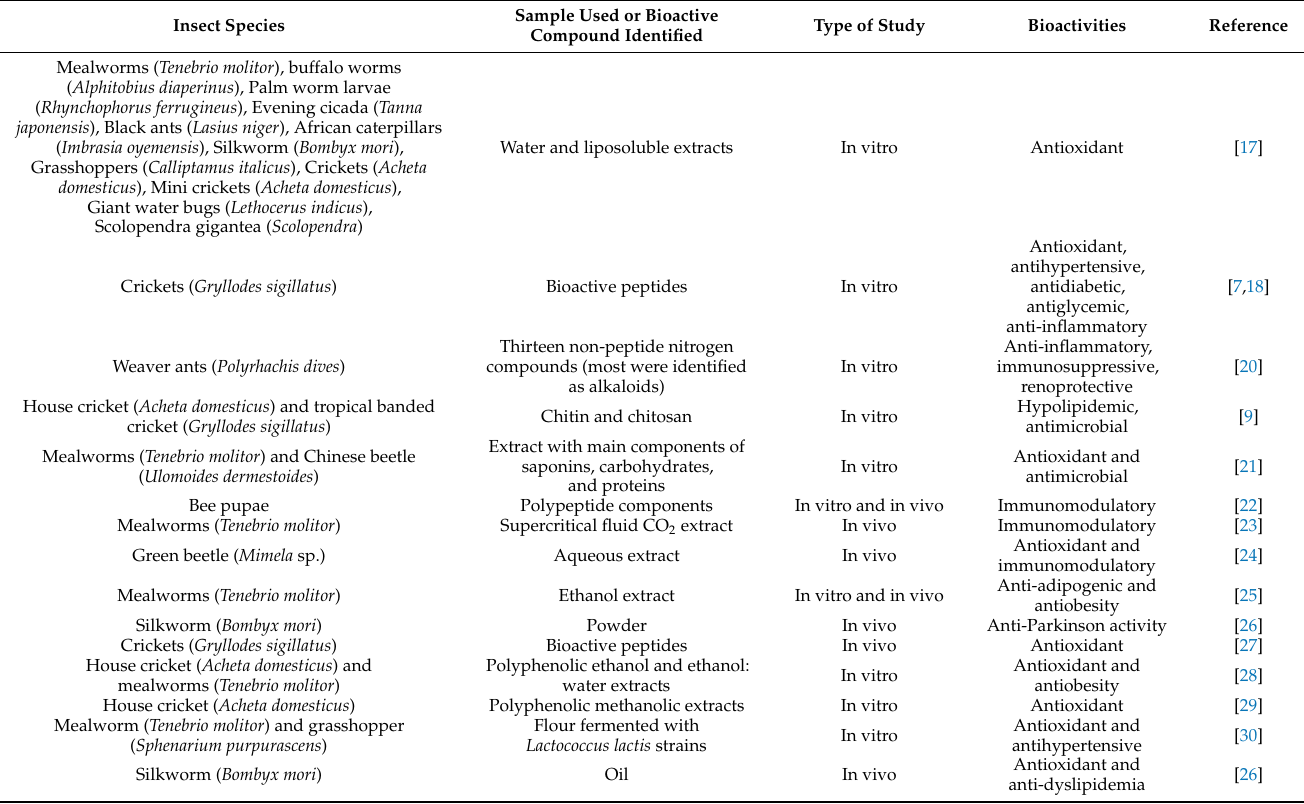
Table 1. Recent scientific literature related to the health benefits of different edible insect